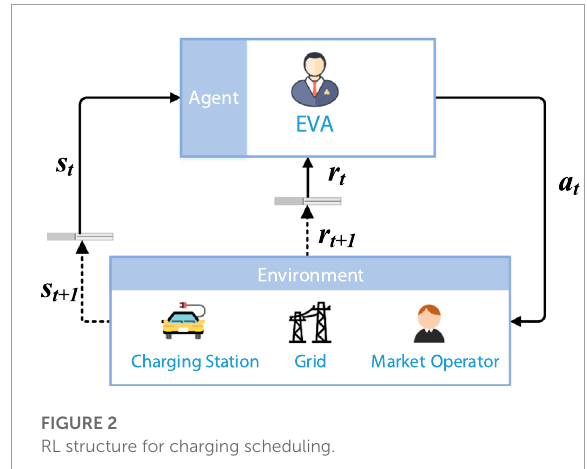
FIGURE 2 RL structure for charging